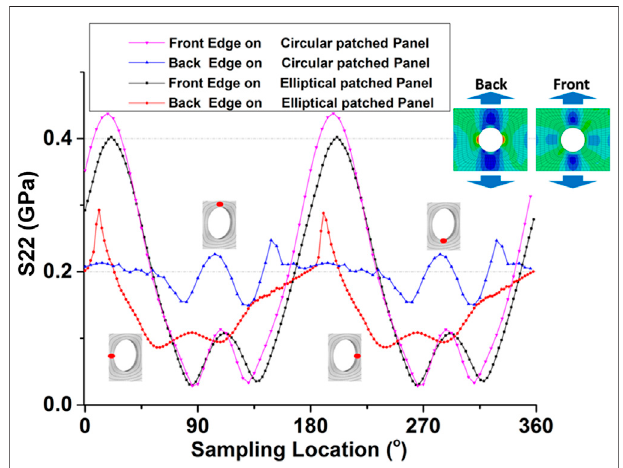
FIGURE 16 | S22 distribution on the edges of the hole of CA- and EA- TFP single-side reinforced (SSR) samples.